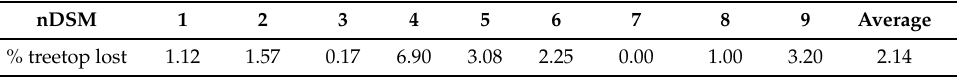
Table 1. Percentage of annotated treetop lost when using nDSM instead of